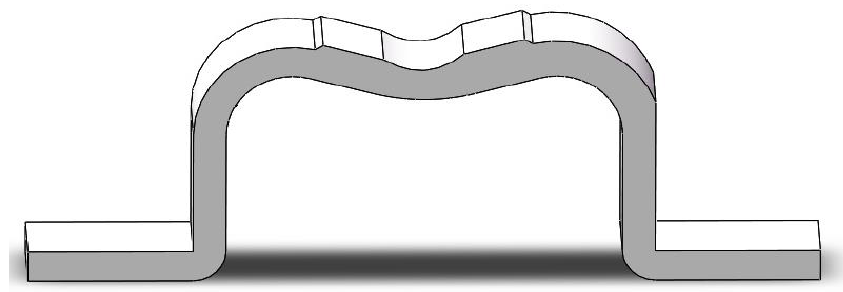
Figure 13. The Optimized constrained flow passage.